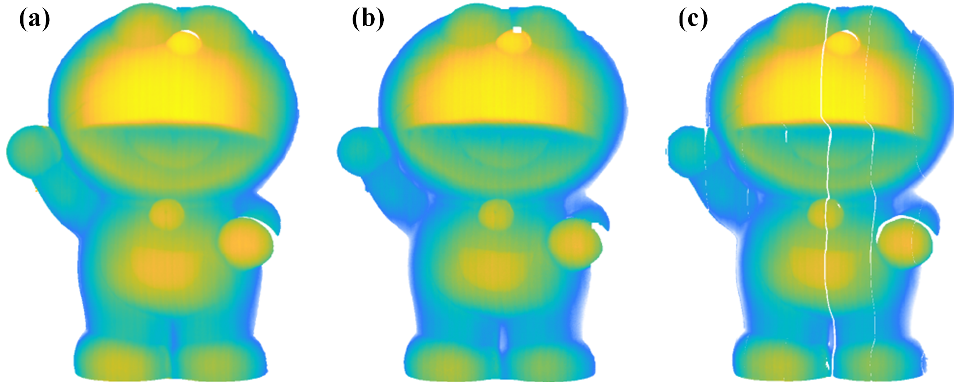
Figure 11. Three-dimensional reconstructions under defocused scenes; ( a ) 3D reconstruction of the proposed method; ( b ) 3D reconstruction of Ref. [32]; ( c ) 3D reconstruction of the conventional method. nGL